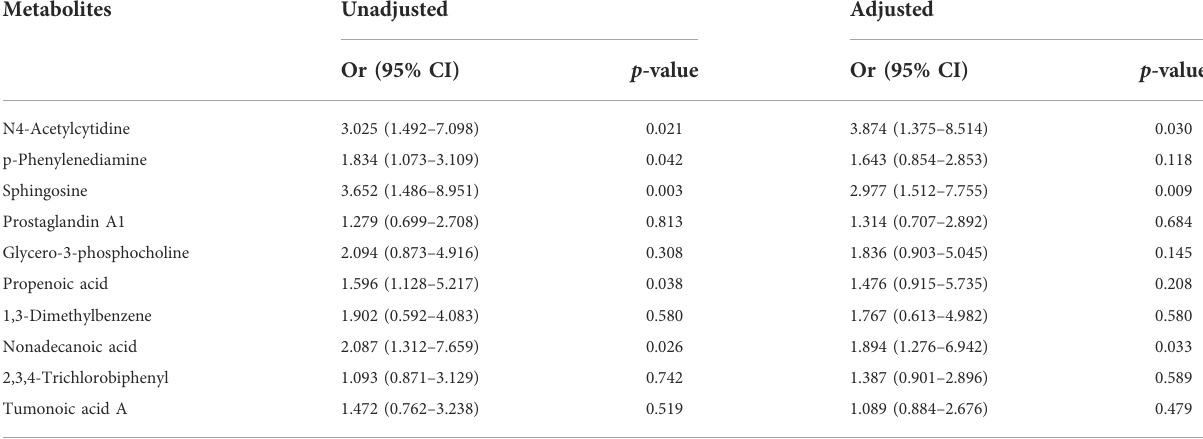
TABLE 5 Unadjusted and adjusted multivariate logistic regression analysis of metabolites associated with hearing recovery.